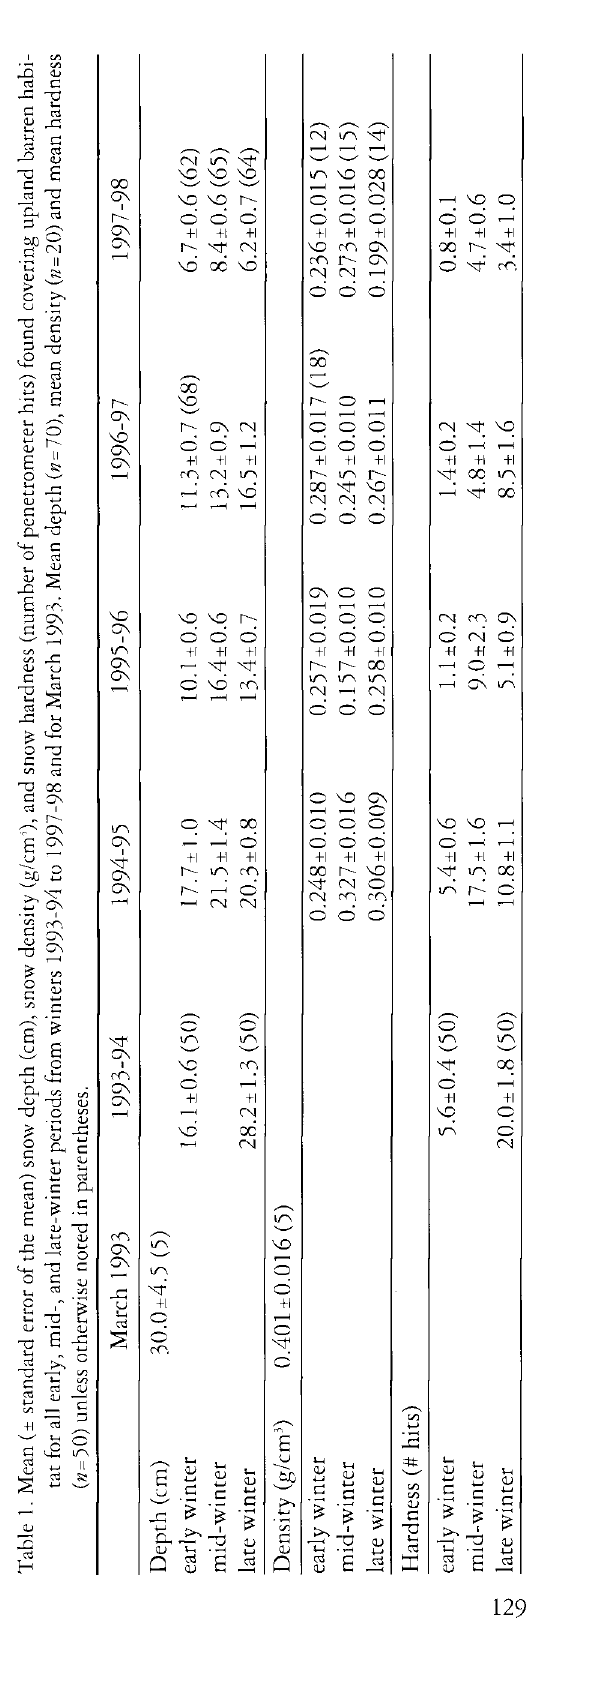
Fig. 4. Median urea nittogenxreatinine ratios (mg/mg) from samples collected between March 1993 and February 1994. The February 1994 histobar includes all samples while the Feb. C histobar documents the median level of only the sacrificed animals. Sample size is indicated above each his